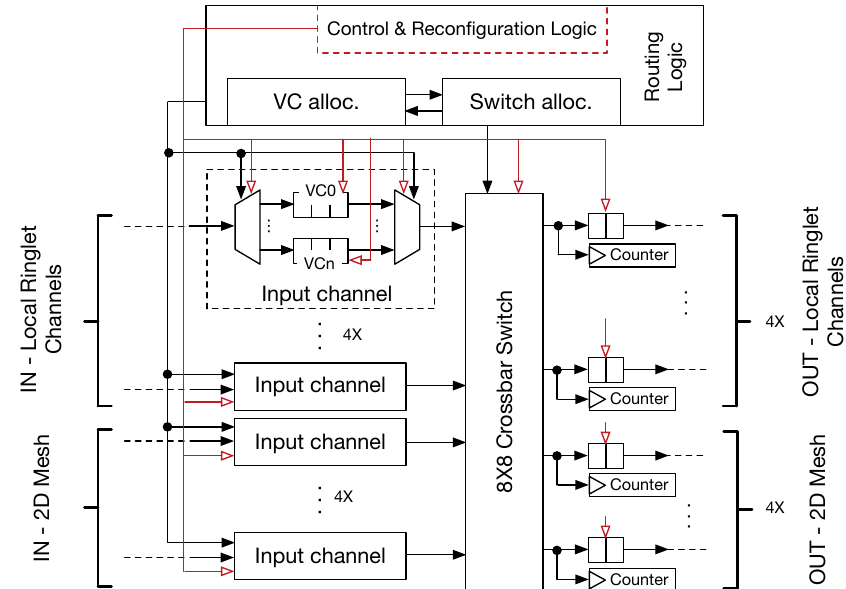
Figure 3. Internal micro-architecture of the 2D-mesh router connecting up to four ringlets. A router with all of the ringlets connected will form a physical tile. Red arrows are the power-gating